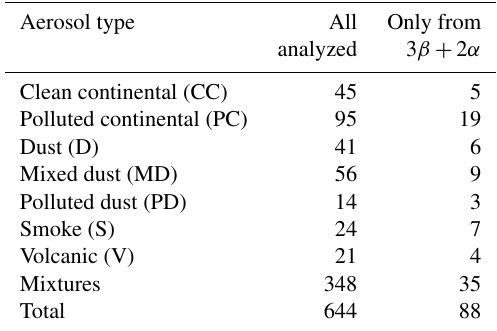
Table 1. Number of classified aerosol layers adapted from Schwarz (2016). The mixtures category is comprised of two or more pure aerosol